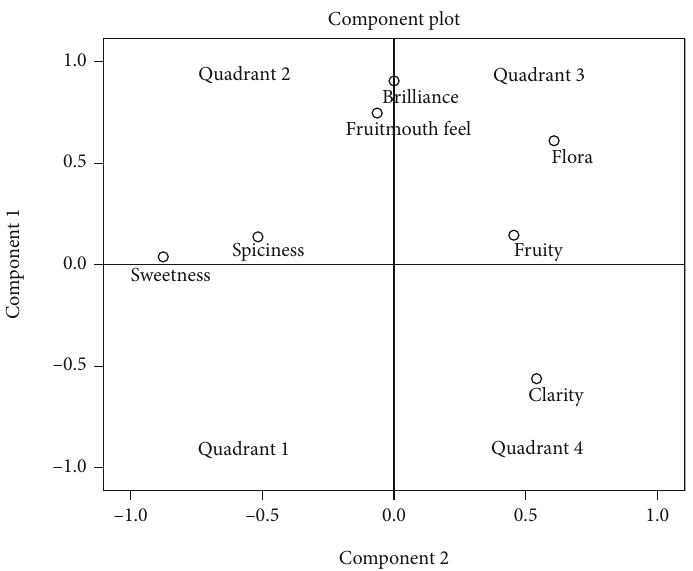
Figure 3: Principle component analysis of preference descriptors ( GM > 50 % ) by a